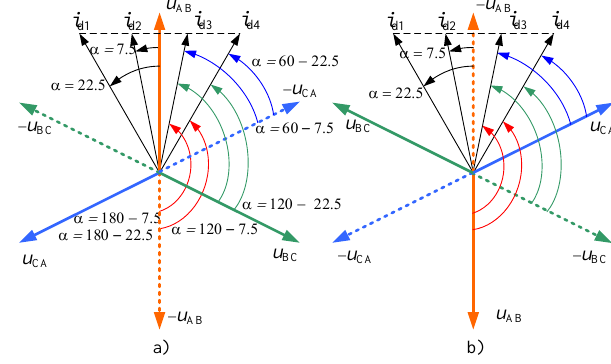
Fig. 15. Vector current diagram of 24-pulse rectifier with electronic phase shift: а) Rectifying mode; b) Inverter mode.